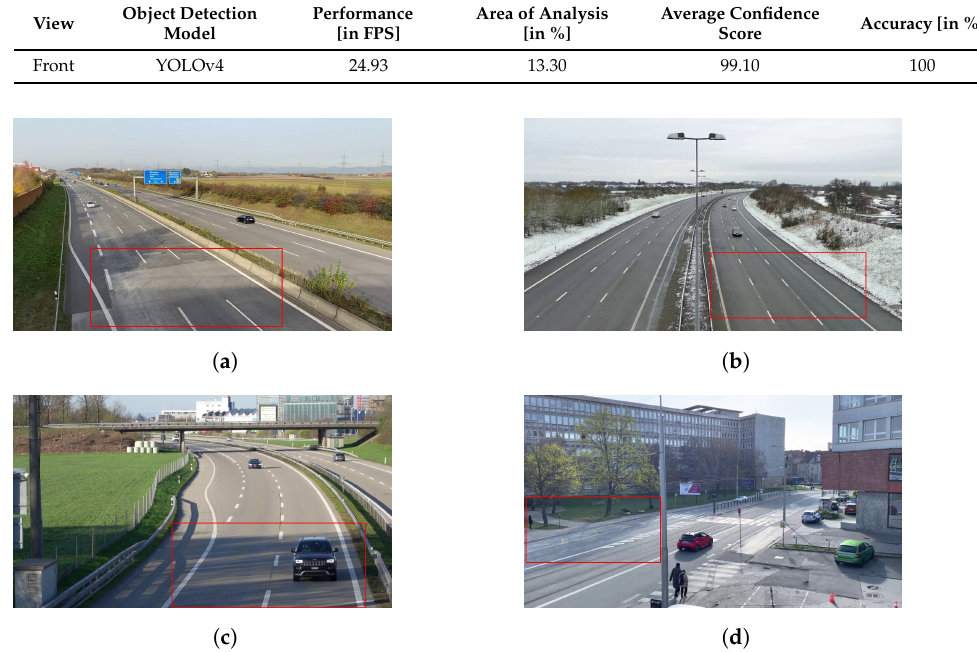
Table 7. Summary from other scenarios.